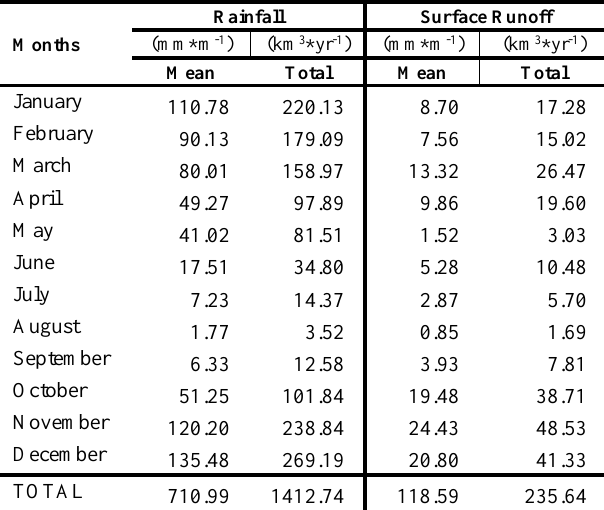
Table 1. Estimated monthly rainfall and surface runoff results of